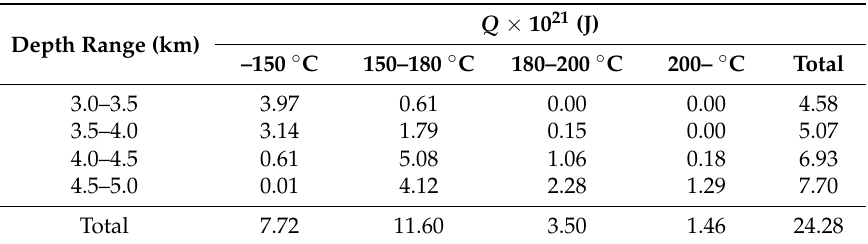
Table 2. Heat content in the Daqing